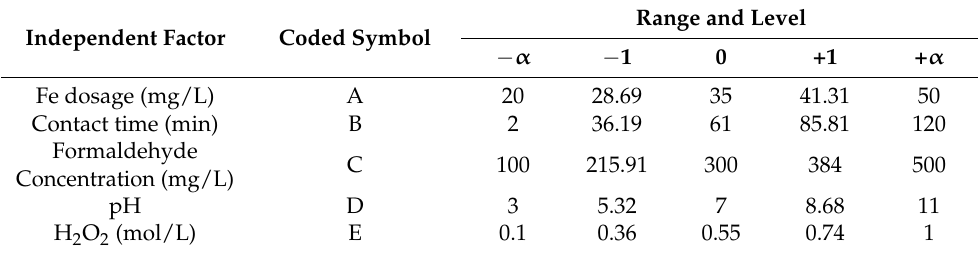
Table 1. The independent variables, along with the levels of the independent variables, in the designed